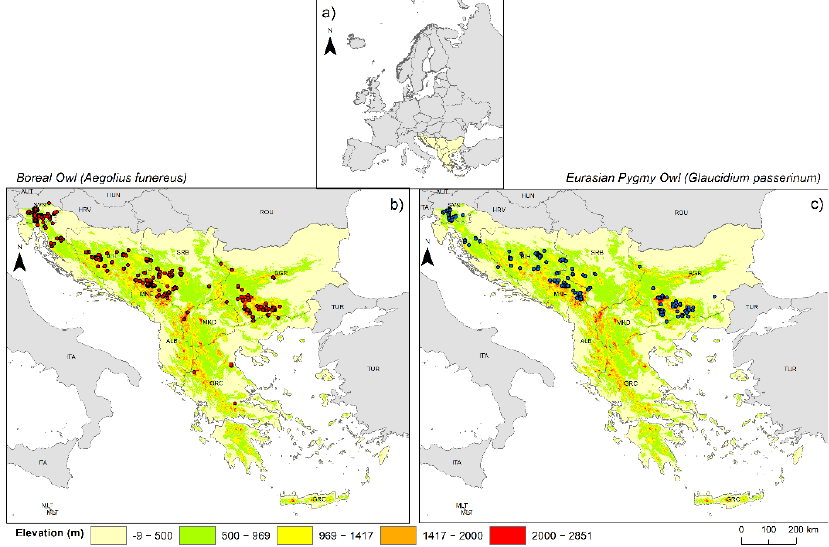
Figure 1. Study area ( a ) at a larger scale. Map of the study area with elevation of the Balkan Peninsula at a smaller scale with points where Boreal Owl ( Aegolius funereus ) ( b ) and Eurasian Pygmy Owl ( Glaucidium passerinum ) were present ( c ).